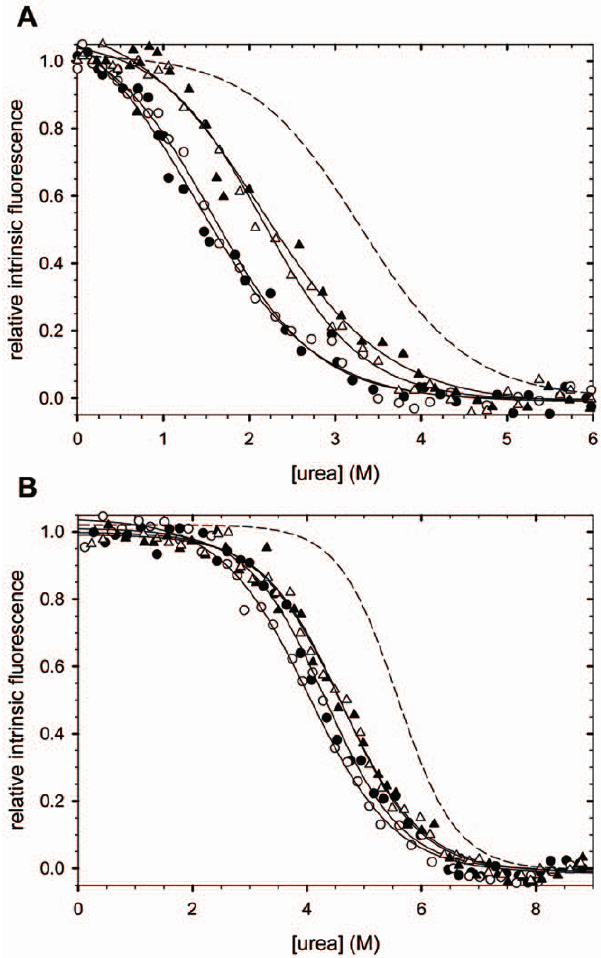
Figure 4. Urea-induced unfolding transitions of the fusions with CspB and MCspB. Variants with 10 alanines are shown with filled symbols; variants with 17 alanines with open symbols; variants with a linker of 3 amino acids are shown as circles; variants with a linker of 16 amino acids as triangles. The dashed line corresponds to the unfolding transition of unlinked CspB/MCspB. The corresponding D G D and m values are indicated in Table 1. Measurements were carried out in 5 mM KH 2 PO 4 , 100 mM NaCl, pH 7.5 at 20 u C. The full reversibility of the transitions is demonstrated in Fig. 2 of the supporting information. A Transitions of the Fusions with CspB, B Transitions of the Fusions with MCspB.